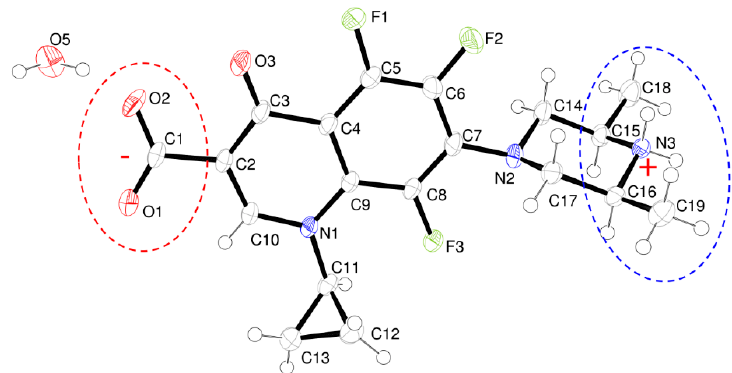
Figure 2. ORTEP view of ORBI hemihydrate form showing the atoms displacement ellipsoids at 50% probability level. Non-hydrogen atoms are arbitrarily labelled and hydrogen atoms are shown as spheres of arbitrary radii. The protonated and deprotonated moieties are marked by dotted circles in blue and red, respectively. The molecules with C15(R),C16(S) configuration was arbitrarily chosen.